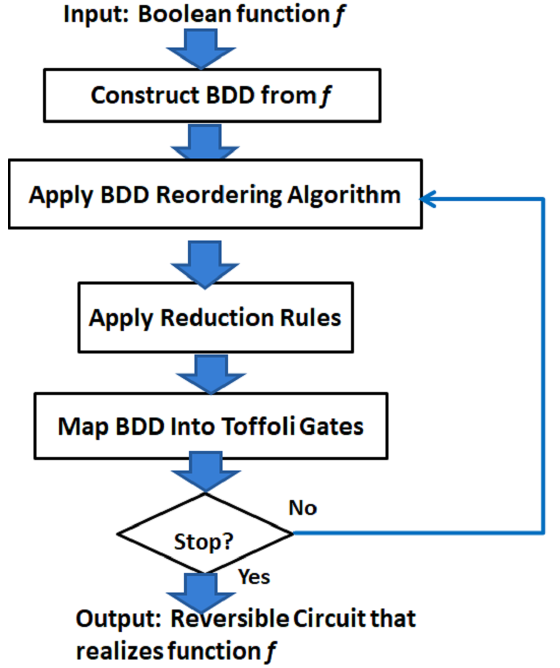
Figure 5. BDD-based synthesis for reversible circuits, integrating the mapping phase in the BDD optimization